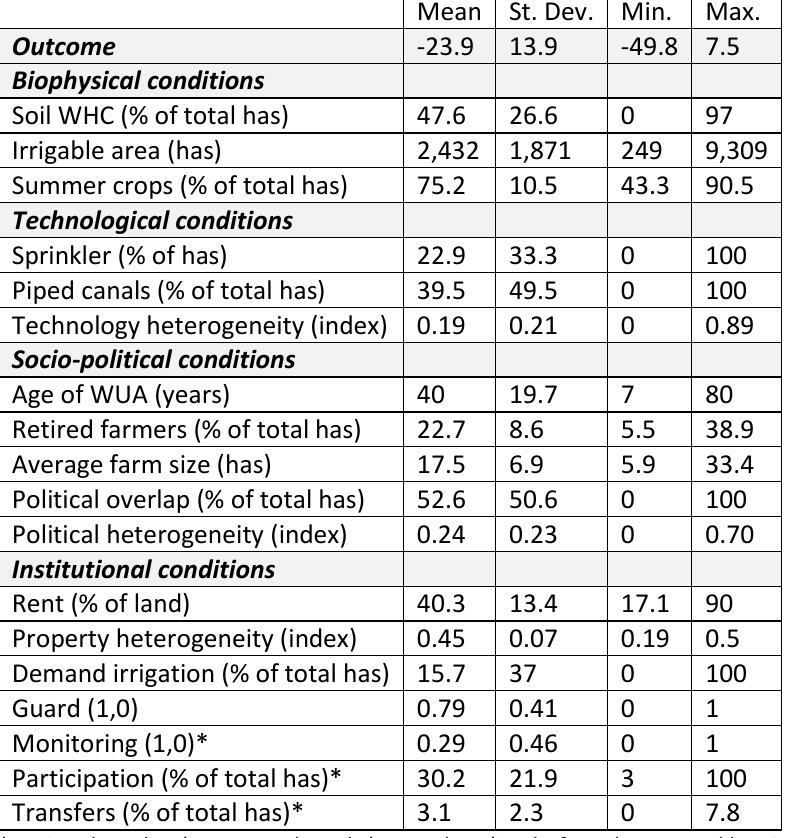
Table A1.3 Descriptive statistics of variables Mean St. Dev. Min.